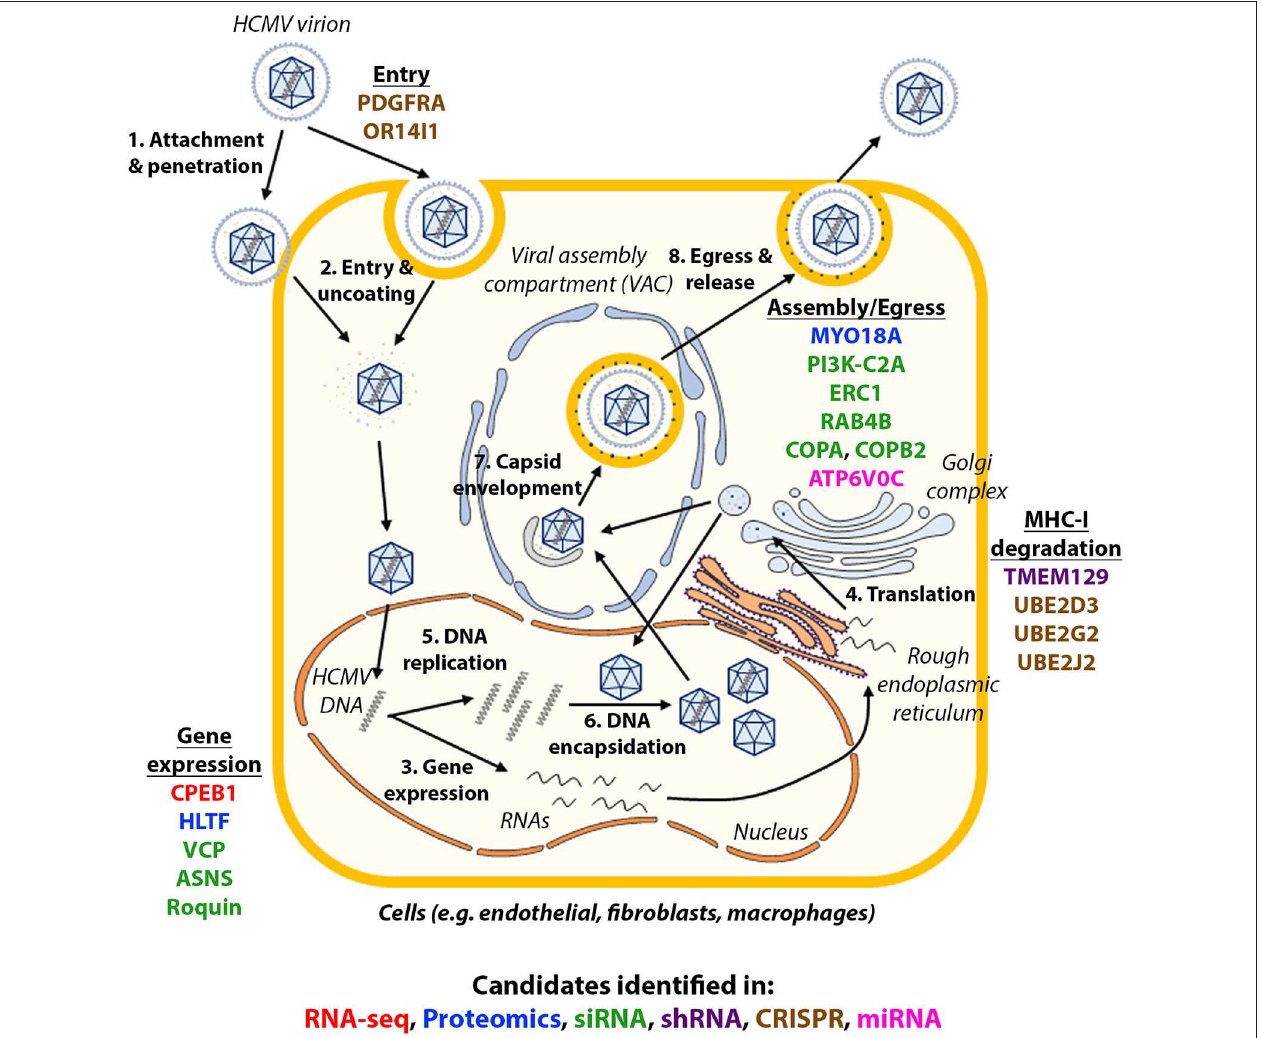
FIGURE 1 | Host factors identified in high-throughput studies and their role in HCMV infection. The life cycle of HCMV is summarized in the figure and candidates identified in each type of high-throughput studies were shown in their approximate functional location. Candidates identified in each type of high-throughput studies are in: red (RNA-seq), blue (proteomics), green (siRNA), purple (shRNA), brown (CRISPR), pink (miRNA).